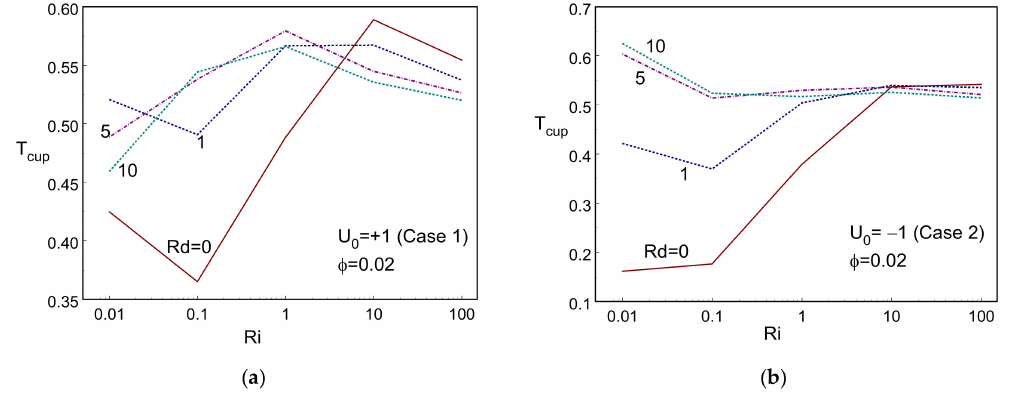
Figure 11. Cup-mixing temperature for di ff erent Ri and Rd values. ( a ) Case 1; ( b ) Case